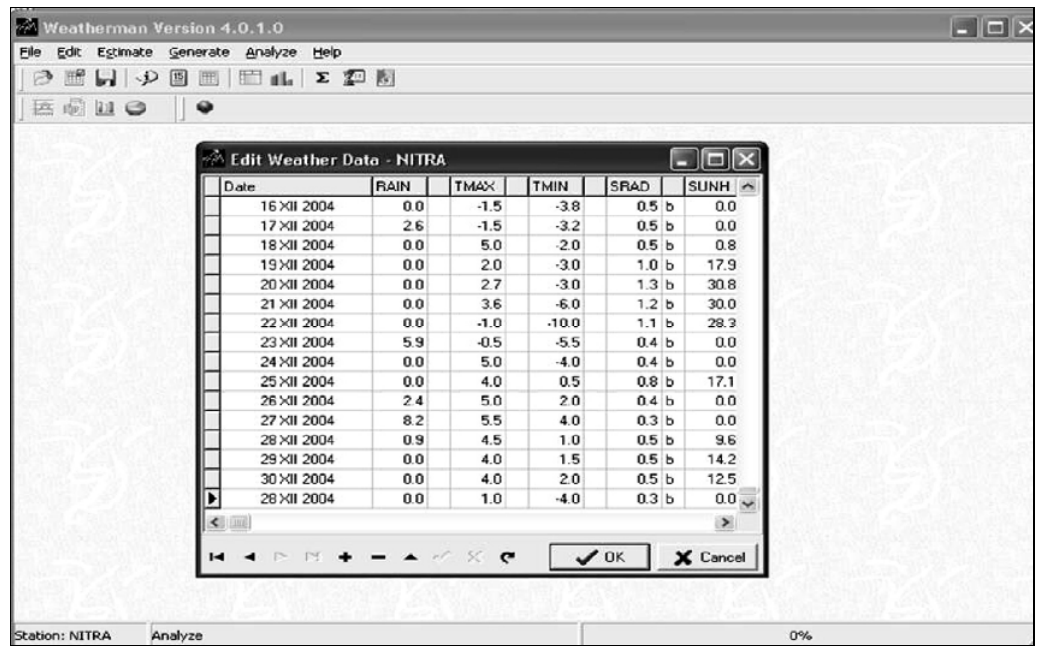
Fig 1 . Meteorological inputs to model from weatherman